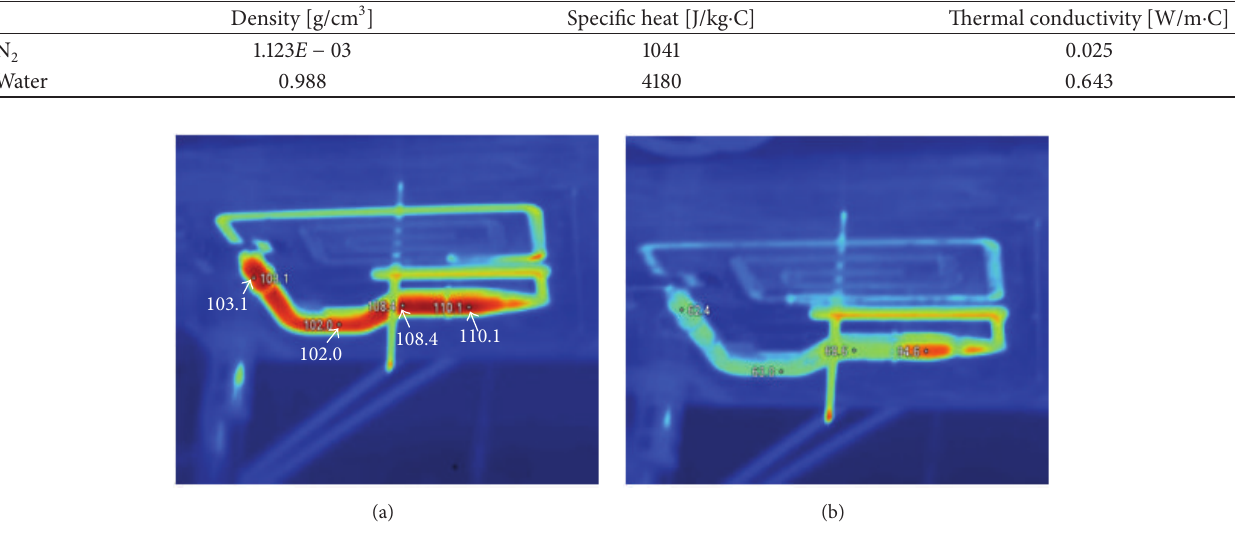
Table 4: Thermal properties of N